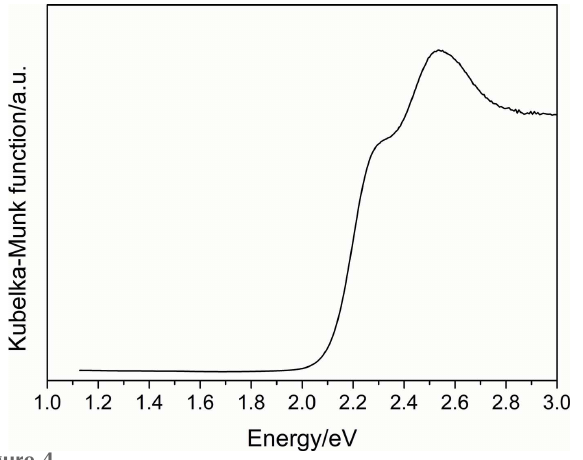
Figure 4 UV–vis diffuse reflectance for the title compound.